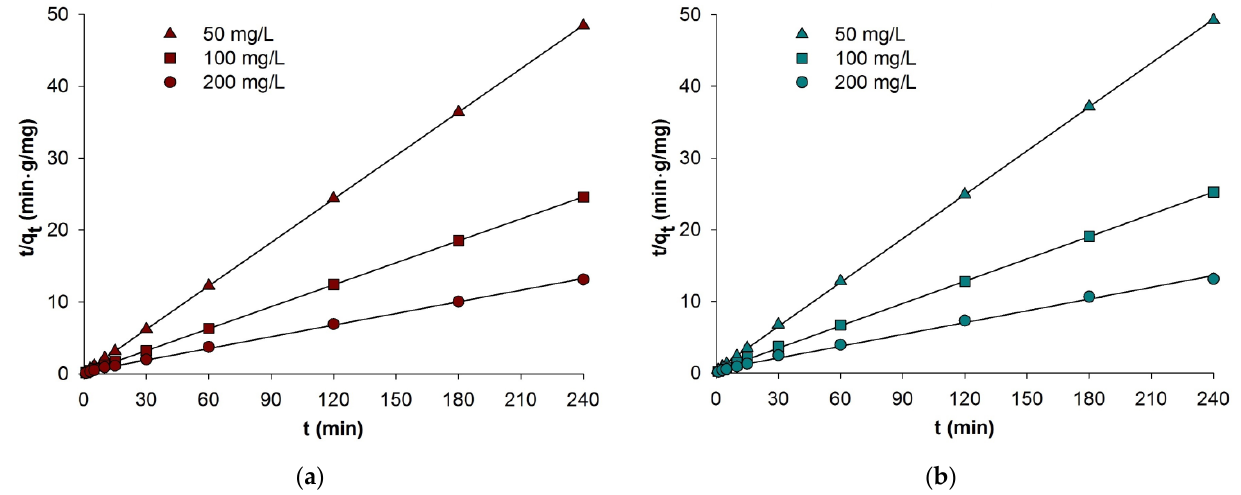
Figure 3. Pseudo-second order kinetic model for BB3 adsorption on ( a ) sawdust and ( b ) Cladium mariscus. Other scientists also determined adsorption kinetics of BB3 as compatible with the PSO equation using various adsorbents [15–19,31,32]. The kinetic parameters obtained by them are depicted in Table